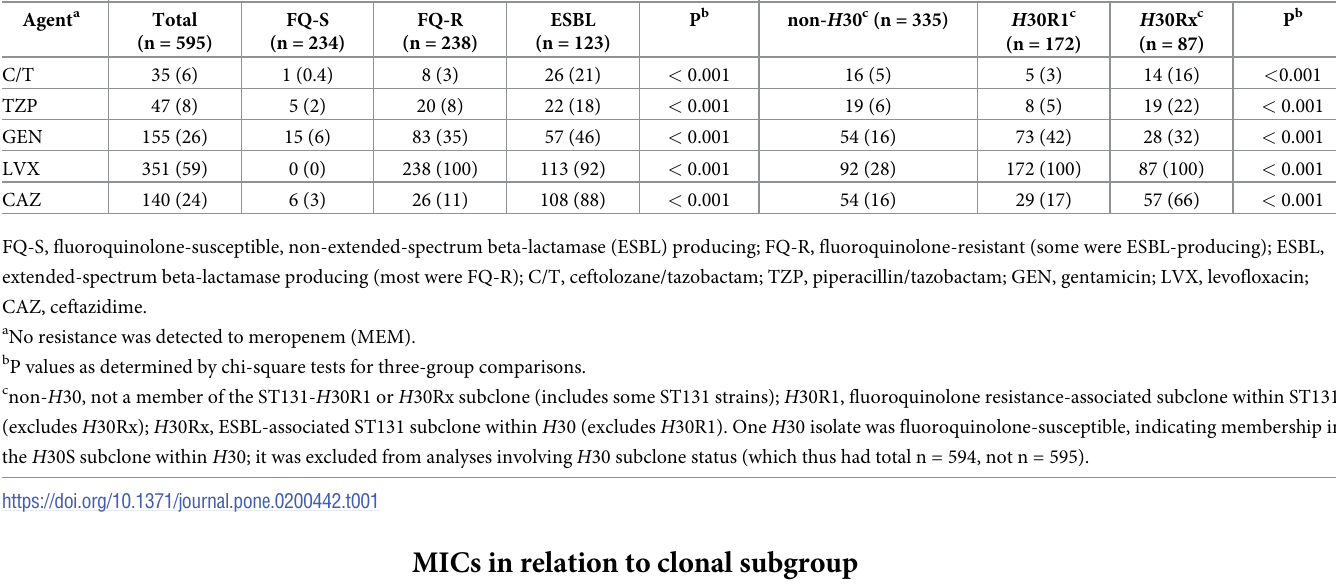
MICs in relation to clonal subgroup The three clonal subgroups (non-ST131- H 30, H 30R1, and H 30Rx) exhibited significant MICs differences for all studied agents except MEM, including in 5 of 6 three-group comparisons and in 12 of 18 pairwise comparisons (Table 3). The rank order of subgroups for MICs varied by agent. For C/T, exceptionally, the rank order of the subgroups (by increasing MICs) was